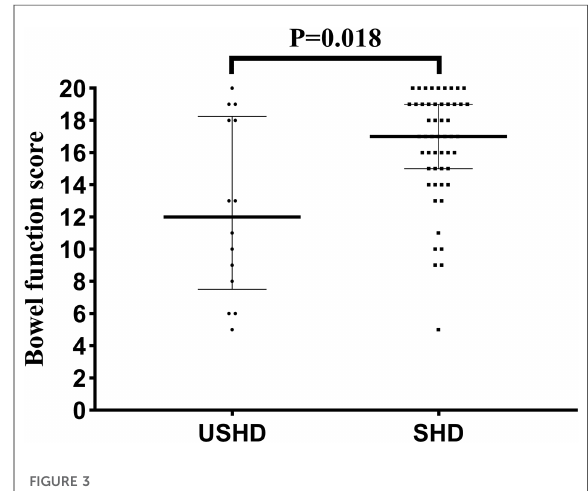
FIGURE 3 BFS for each patient in the USHD group and the SHD